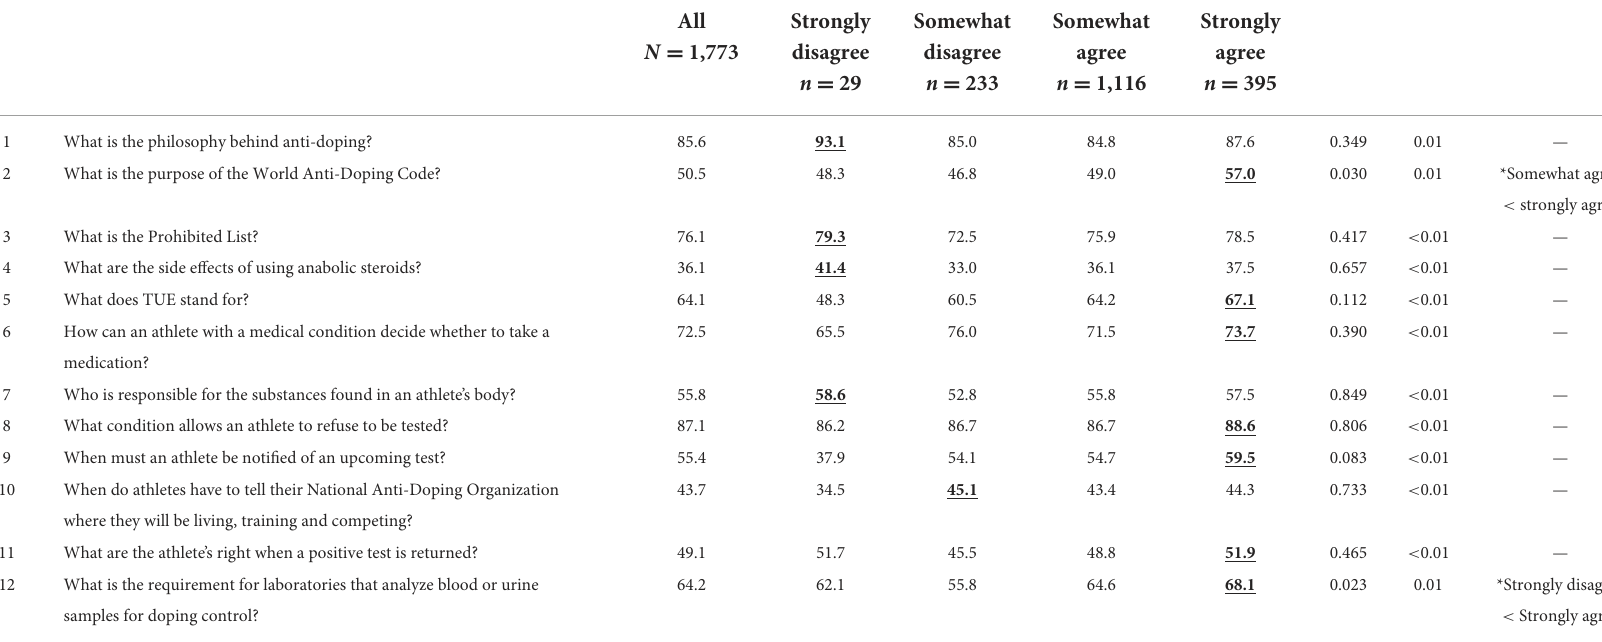
TABLE 3 Correct answers rate by the level of willingness-to-learn for each ALPHA question.